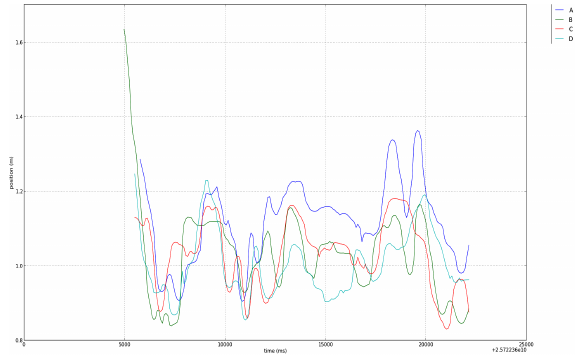
Figure 10: Variation of the trajectories along the Z